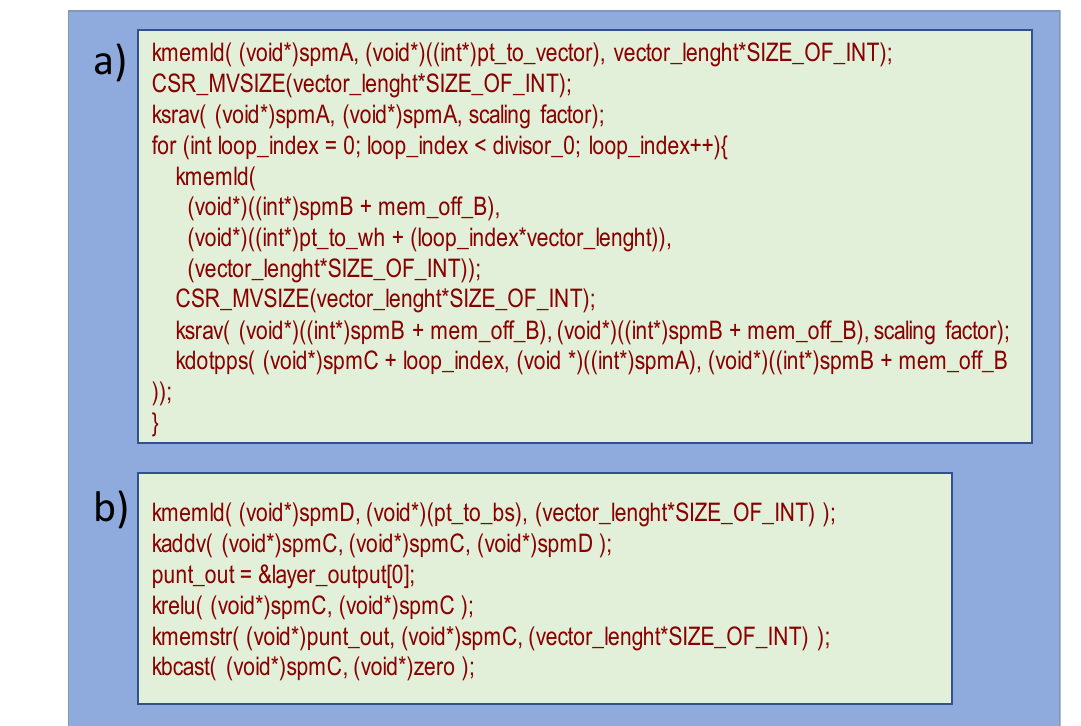
Figure 13. Fully-connected layer operations. ( a ) Dot-product kernel; ( b ) Bias addition and ReLu (Fully-connected Layer: 19, 20, 21).